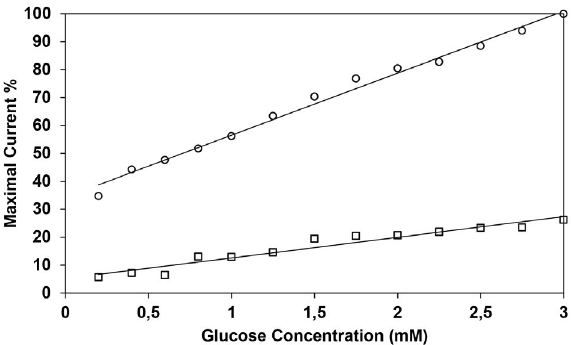
Figure 4. Current response of POA based electrode prepared apply- ing different scan rates; O: 50 mV/s;  : 100 mV/s.